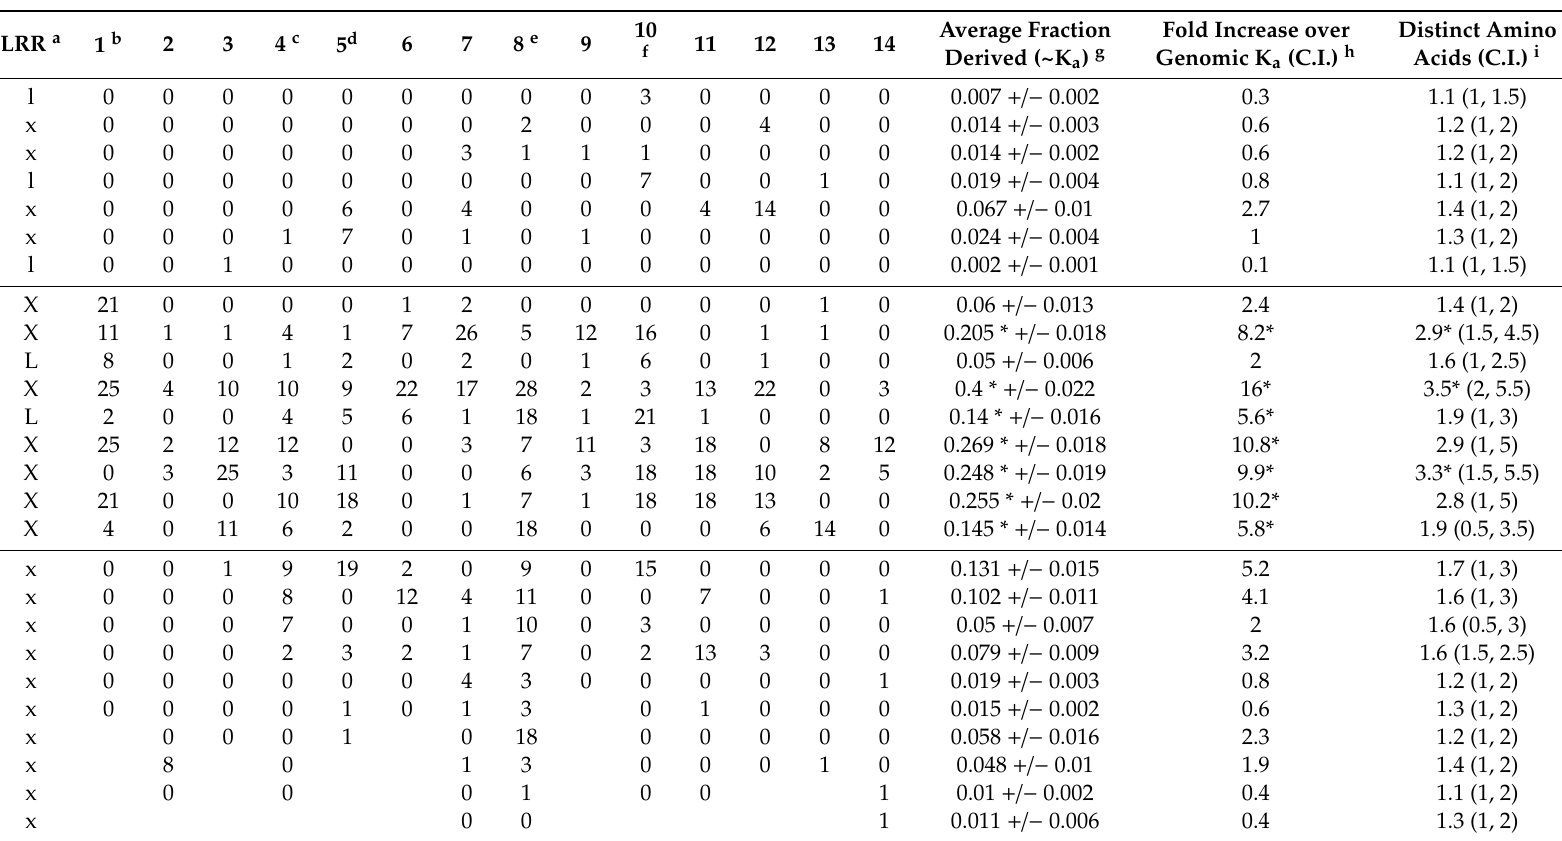
Table 5. Coding sequence diversity in the hypervariable (“X”) sites of the 14 leucine-rich repeat (LRR) subdomains in 30 alleles in the RPP8 gene family. Table shows the number of derived amino acids, typically out of 30, present at each amino acid residue in each LRR of all 30 fully sequenced RPP8